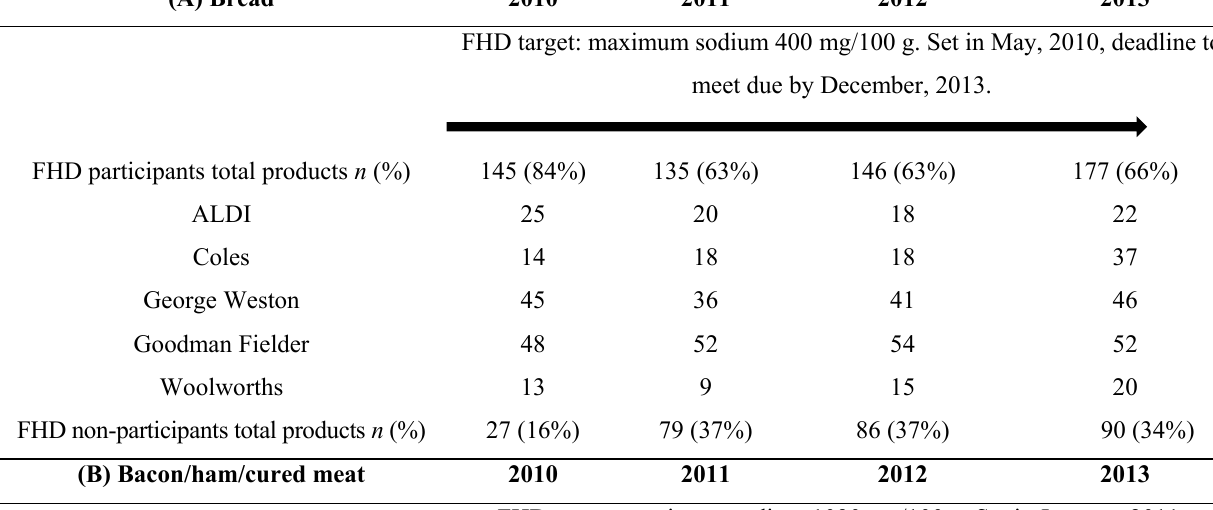
FHD target: maximum sodium 1090 mg/100 g. Set in January, 2011, deadline to meet due by December, 2013.